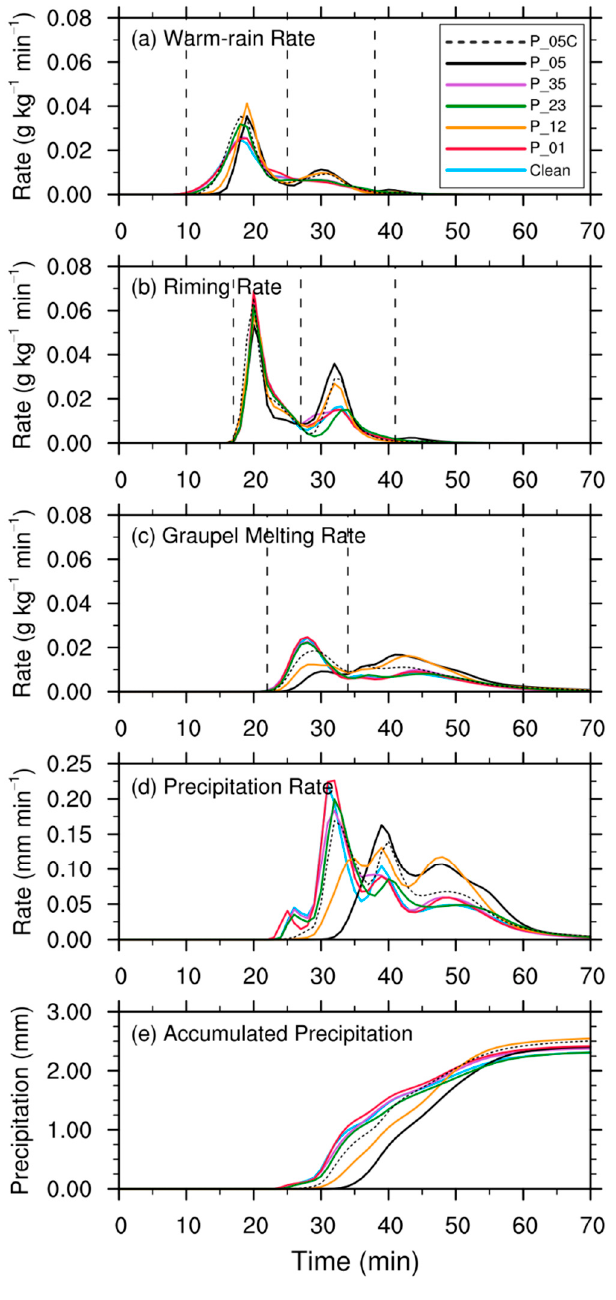
Figure A3. The time series of the rates of the three microphysical processes, precipitation rates, and accumulated precipitation of all the simulations. Similar to Figure 5 but the P_05C simulation is included in.